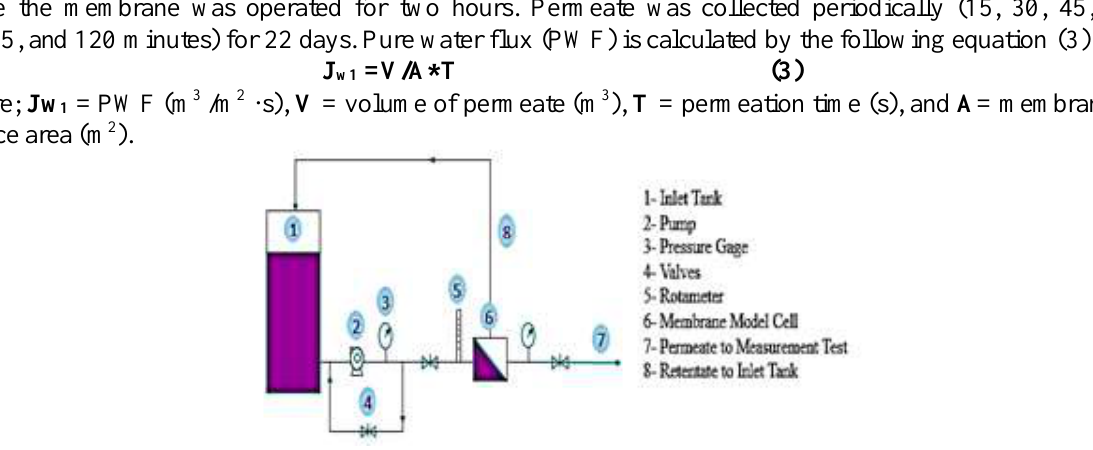
Figure 3: Schematic diagram of ultrafiltration experimental system.